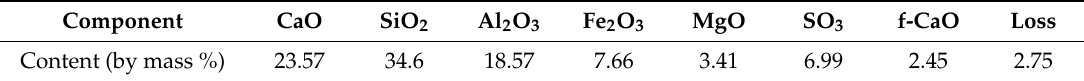
Table 3. Chemical composition of high-sulphur fly